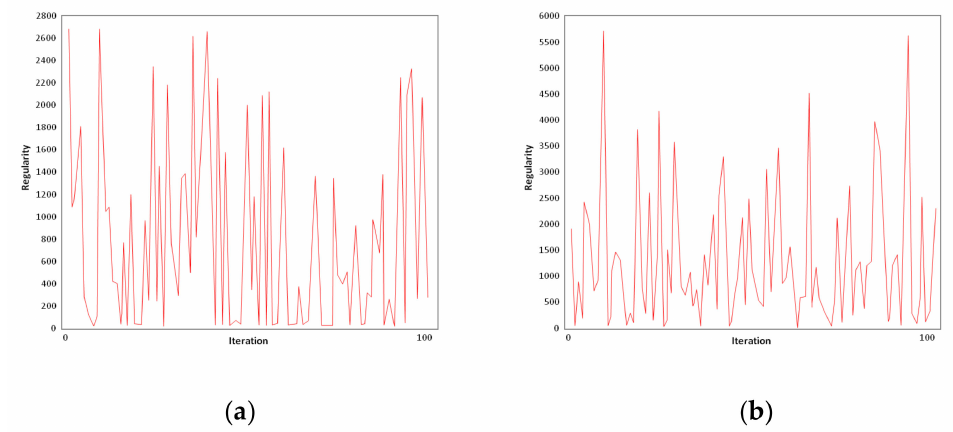
Figure 17. The regularity in case of cycle crossover ( a ) and partially matched crossover operator ( b ).